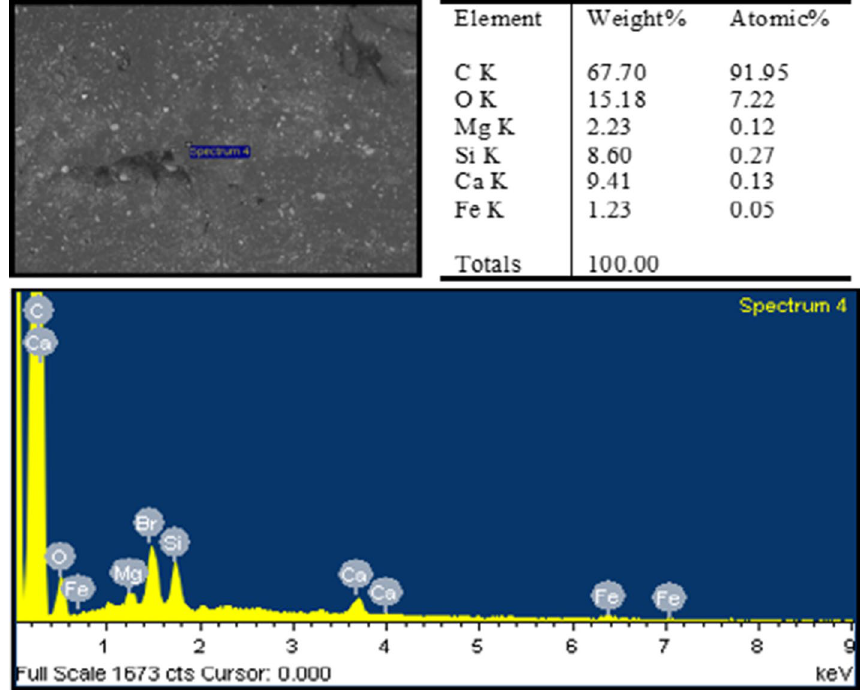
Fig. 2 SEM images of adsorbent: Neem leaf powder showing the low agglomerated with average spherical particles Fig. 3 EDS analysis of